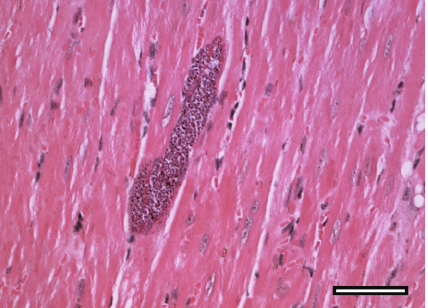
Figure 3: Lack of sensing of amastigote nests could contribute to parasite perpetuation and pathology in the chronically infected heart. Lack of sensing could occur independently of the origin of cardiomyocyte-invading trypomastigotes, that is, from a local ruptured nest or metastasis from a distant niche. The heart picture shown corresponds to a C3H/HePAS mouse infected for more than 200 days with 10 6 Sylvio X10/4 trypomastigotes. The tissue section was stained with hematoxylin-eosin. Bar corresponds to 100 𝜇 m (reproduced from C. R. F. Marinho, Microbes and Infection [64] with permission from